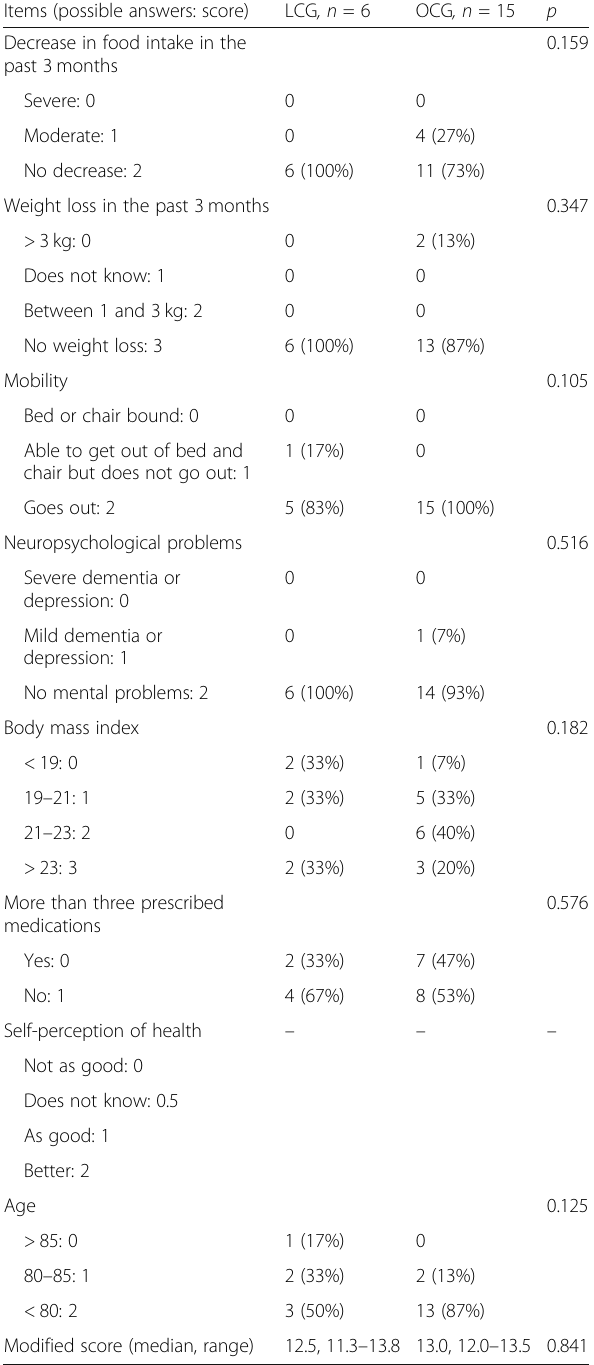
Table 1 Preoperative evaluation using the G-8 geriatric screening